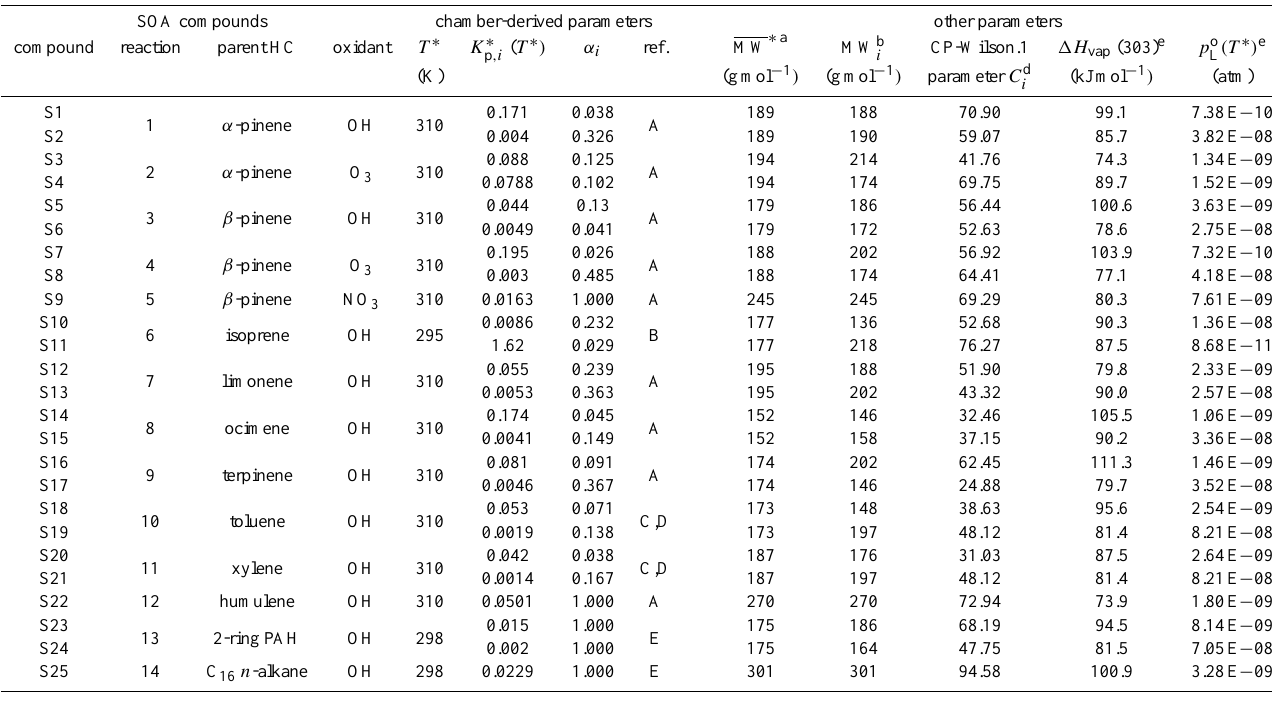
Table 1. Assumed properties of 25 SOA and 15 POA surrogate compounds, and water. SOA